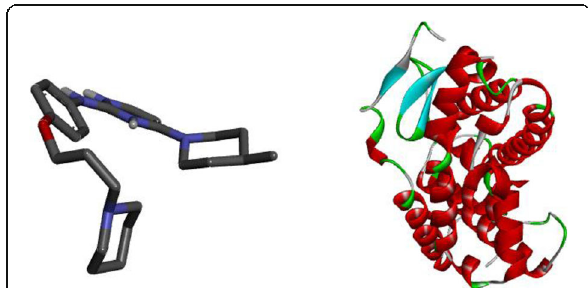
Fig. 5 3D structure of the ligand and prepared protein receptor